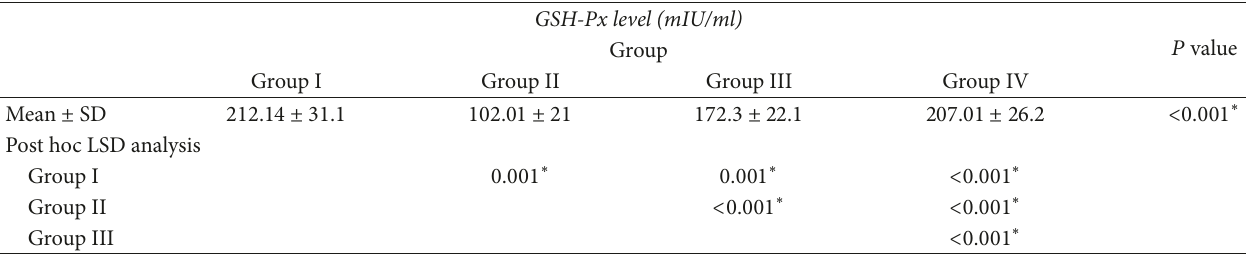
Table 3: One-way ANOVA statistical analysis of GSH-Px level in different experimental groups (𝑛 = 10) .